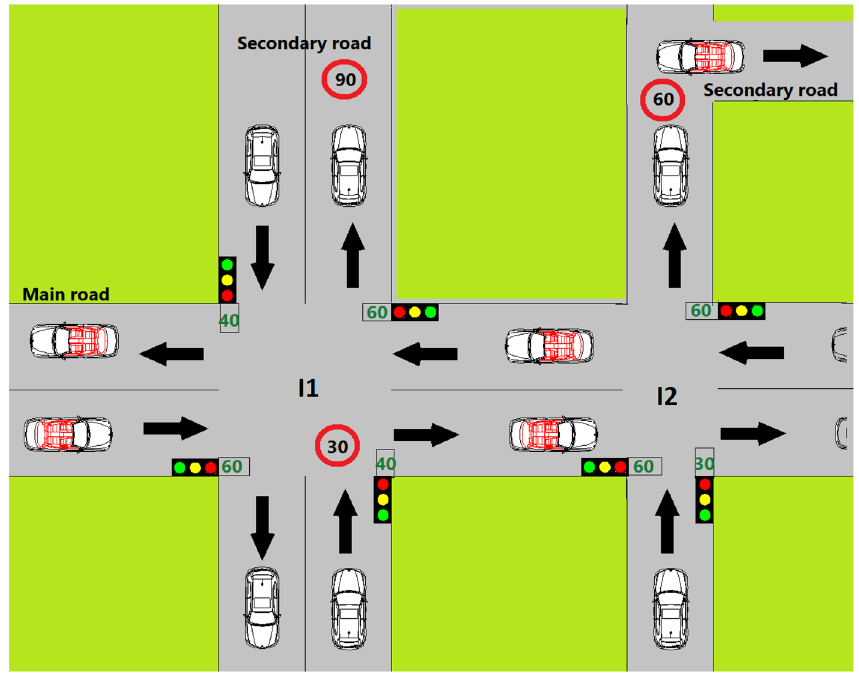
Figure 2. VANET-enabled traffic light boxes in each road direction.